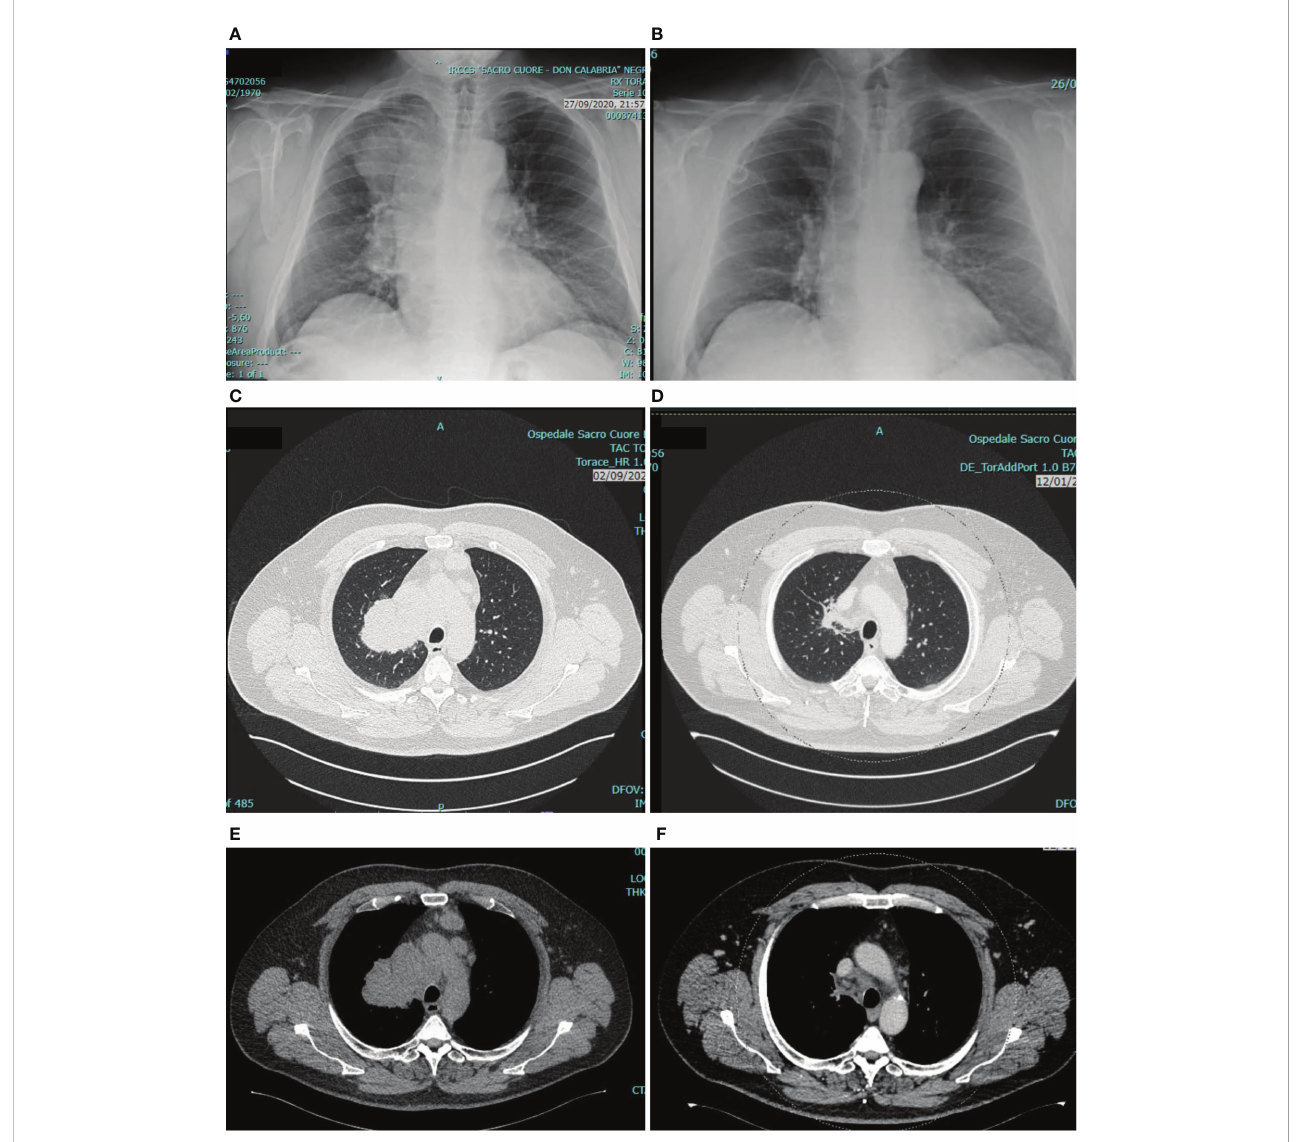
FIGURE 1 Tumor assessment at baseline and after 4 cycles of pembrolizumab/carboplatin/pemetrexed. The fi gure shows chest X-ray before (A) and after (B) treatment, and chest CT scan before (C, E) and after (D, F) treatment. As compared with baseline, tumor assessment after 4 cycles revealed a deep response of the primary tumor in the upper right pulmonary lobe, and a reduction of para-tracheal and pre-vascular mediastinal pathologic lymph